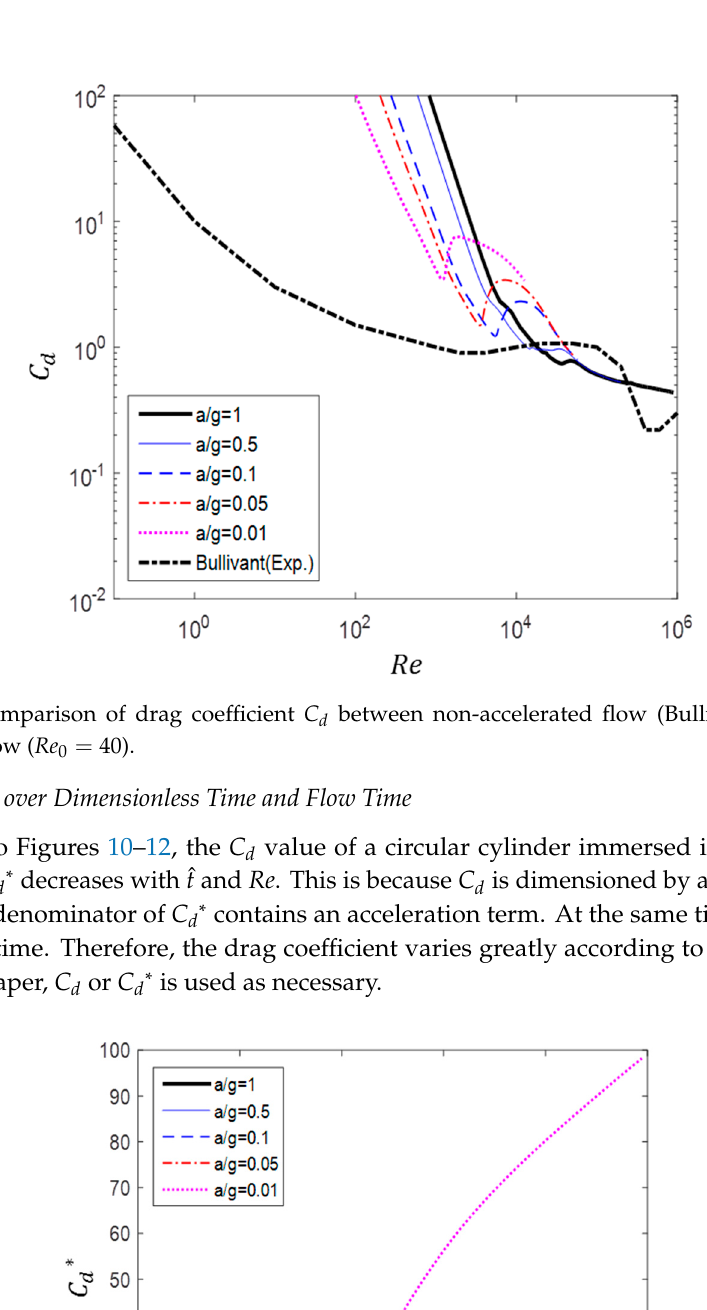
Figure 11. Dimensionless time variation of drag coefficient 𝐶 (cid:3031) ( 𝑅𝑒 (cid:2868) = 40 ) According to Figures 10 and 11, a lower acceleration results in larger 𝐶 (cid:3031) at the same dimensionless time. However, more flow time is required to achieve the same change in dimensionless time with lower accelerations. For example, the case of a / g = 10 takes 10 times longer to achieve the flow time of the case of a / g = 1. Figure 12 shows the variation in 𝐶 (cid:3031)∗ with flow time t . The results show that the smaller the acceleration, the smaller the value of 𝐶 (cid:3031)∗ . In addition, the inflection point at which the slope increases sharply is shown in the cases of a / g = 0.1, 0.05, and 0.01.